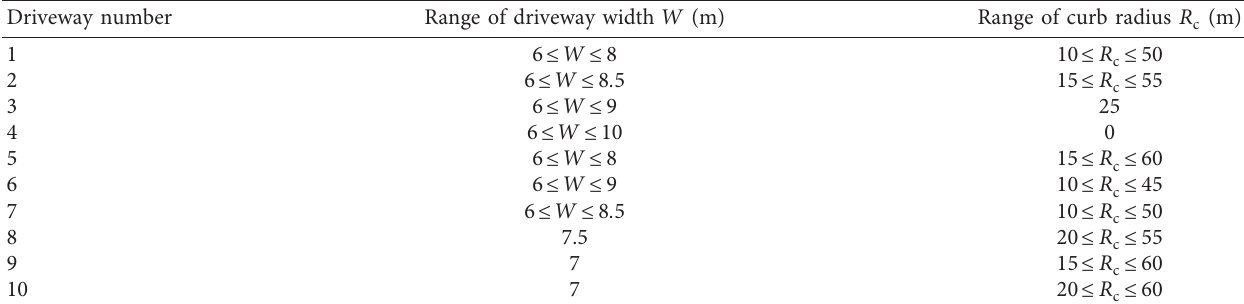
Table 8: Alternative driveway design range.